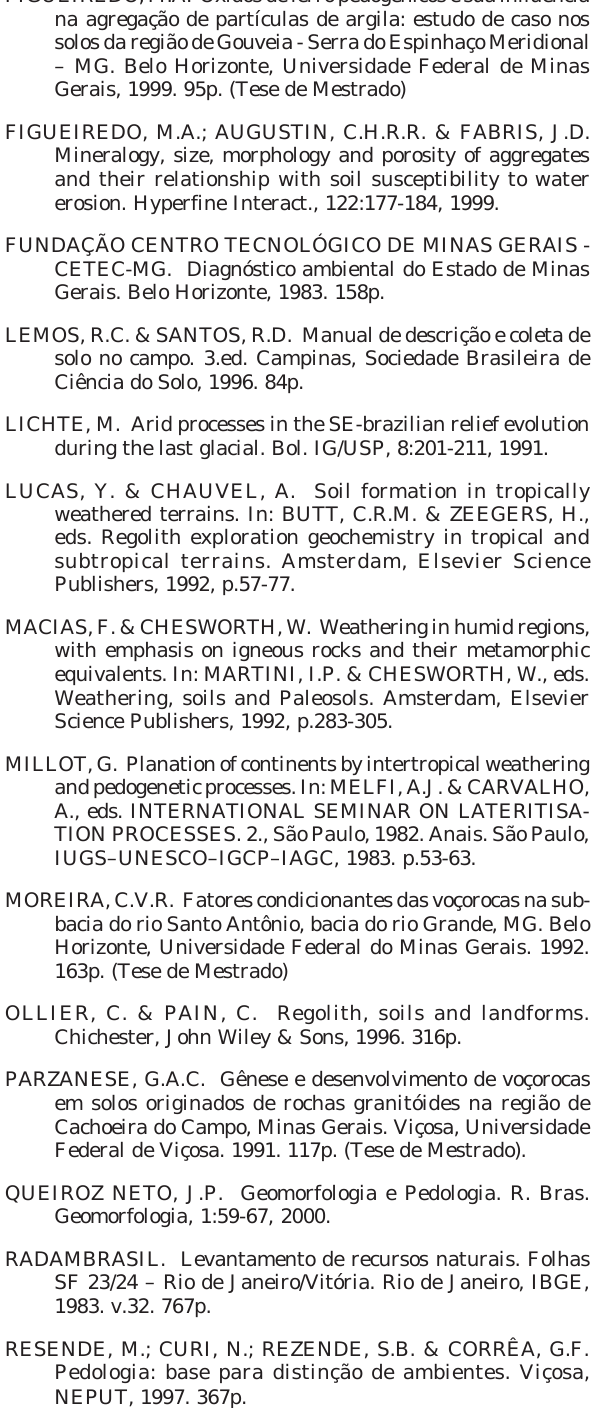
FIGUEIREDO, M.A. Óxidos de ferro pedogênicos e sua influência na agregação de partículas de argila: estudo de caso nos solos da região de Gouveia - Serra do Espinhaço Meridional – MG. Belo Horizonte, Universidade Federal de Minas Gerais, 1999. 95p. (Tese de Mestrado) FIGUEIREDO, M.A.; AUGUSTIN, C.H.R.R. & FABRIS, J.D. Mineralogy, size, morphology and porosity of aggregates and their relationship with soil susceptibility to water erosion. Hyperfine Interact., 122:177-184, 1999. FUNDAÇÃO CENTRO TECNOLÓGICO DE MINAS GERAIS - CETEC-MG. Diagnóstico ambiental do Estado de Minas Gerais. Belo Horizonte, 1983.